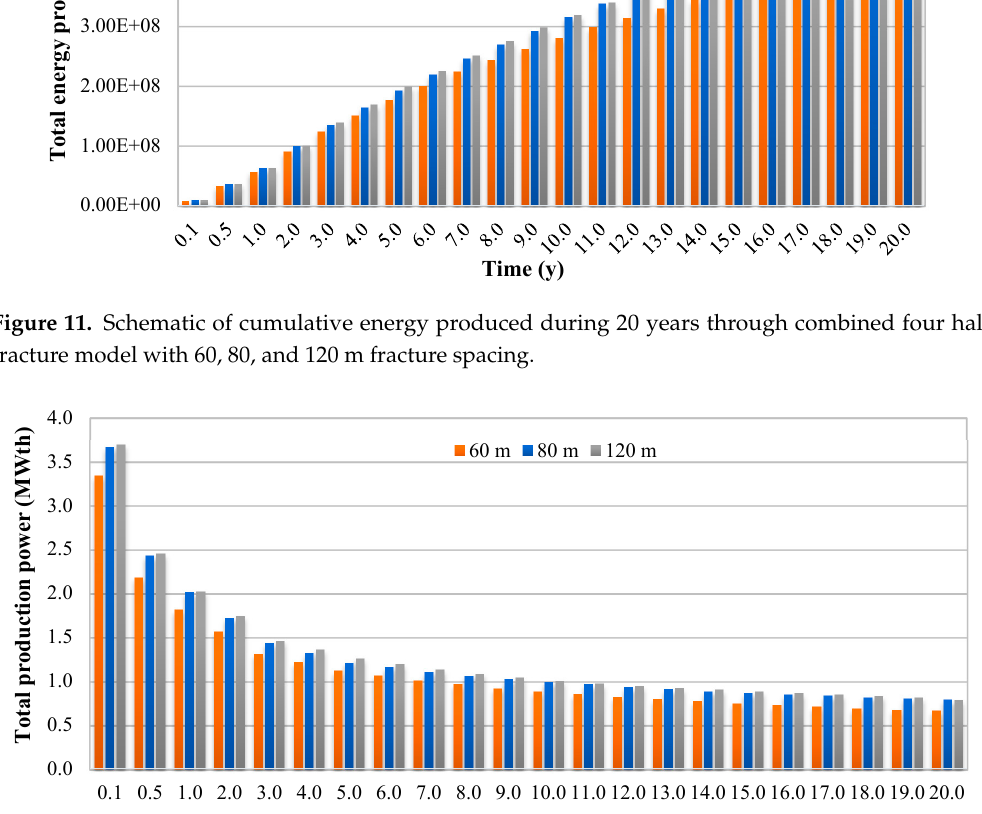
Figure 12. Schematic of heat production power during 20 years through the combined four half fracture model with 60, 80, and 120 m fracture spacing.